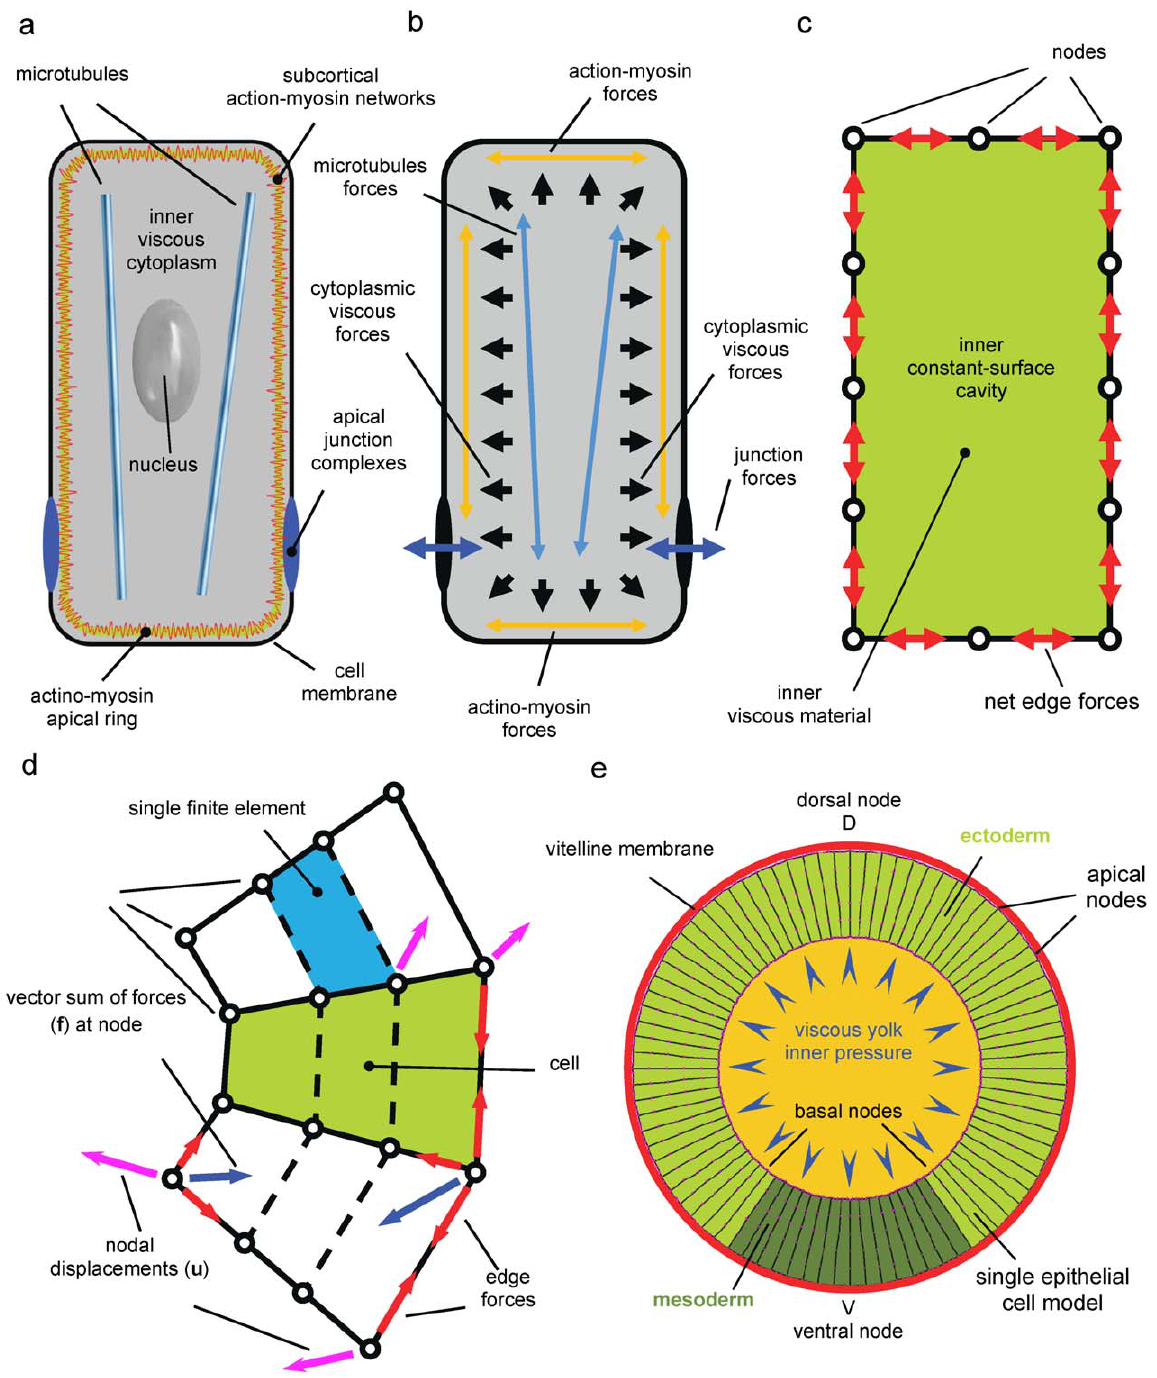
Figure 2. Schematic of the multi-scale model of the 2Dsection of the Drosophila embryo. ( a ) Biological architecture of the Drosophila single epithelial cell. ( b ) Each architectural constituent of the epithelial cell plays a structural role during cell shape changes. Such roles can be either active or passive, depending on whether that constituent is able to generate force or it is deformed by forces actively generated by neighbouring elements. Actin-myosin forces are known to be active systems for force generation whereas microtubules are known to maintain stiffness. Apical junction complexes, instead, keep cell junctions connected and, therefore, transmit forces from one cell to other cells in the epithelium. The inner cytoplasm is a viscous incompressible fluid that resists and responds to cell compression by exerting an inner pressure. ( c ) In order to build a finite element model of the single epithelial cell, the phenotypical effects of the complex force fields originating from the molecular level can be thought as an equivalent field of net forces acting along the cell edges. The incompressibility of the inner cytoplasm can be simulated by enforcing the surface of the region enclosed by the cell membrane to remain constant in time. ( d ) Individual cells (green) are broken into quadrilateral finite elements (blue), which are used to calculate the forces generated by their passive (viscous) components during each time step t i of the simulation. Elements are joined to each other at nodes, and the set of forces (blue arrows) that would be needed to drive a particular set of nodal motions u i (magenta arrows) is denoted by f i . These passive forces f i and their corresponding displacements u i are related by Eqn. (1). The forces generated by active cellular components are